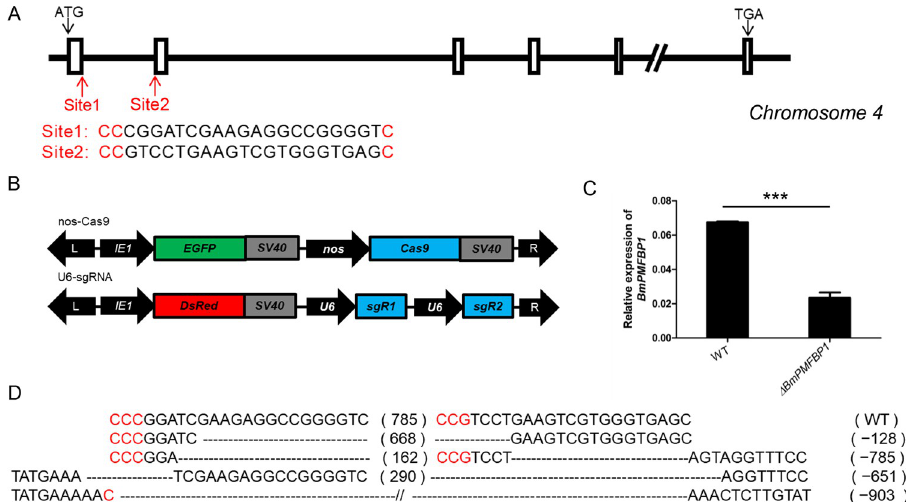
Fig 2. Construction of BmPMFBP1 mutants using the binary transgenic CRISPR/Cas9 system. (A) Schematic of the BmPMFBP1 gene structure and sgRNA target sites. The boxes indicate the coding exon, the black arrows indicate the start and stop codon, the red arrows indicate the two target sites located in exons 1 and exons 2. (B) Schematic of the binary transgenic CRISPR system vectors for obtaining BmPMFBP1 mutants. (C) The mRNA expression level of BmPMFBP1 in three individual WT and mutant testes at L5D4. The asterisks ( ��� ) indicate the significant differences (P < 0.001) relative to WT. (D) Examples of mutations induced by CRISPR/Cas9 system. The sequence of the wildtype is displayed at the top. The dotted lines indicate the deleted residues, the PAM sequence is in red, the number of the nucleotides deleted are shown on the right.